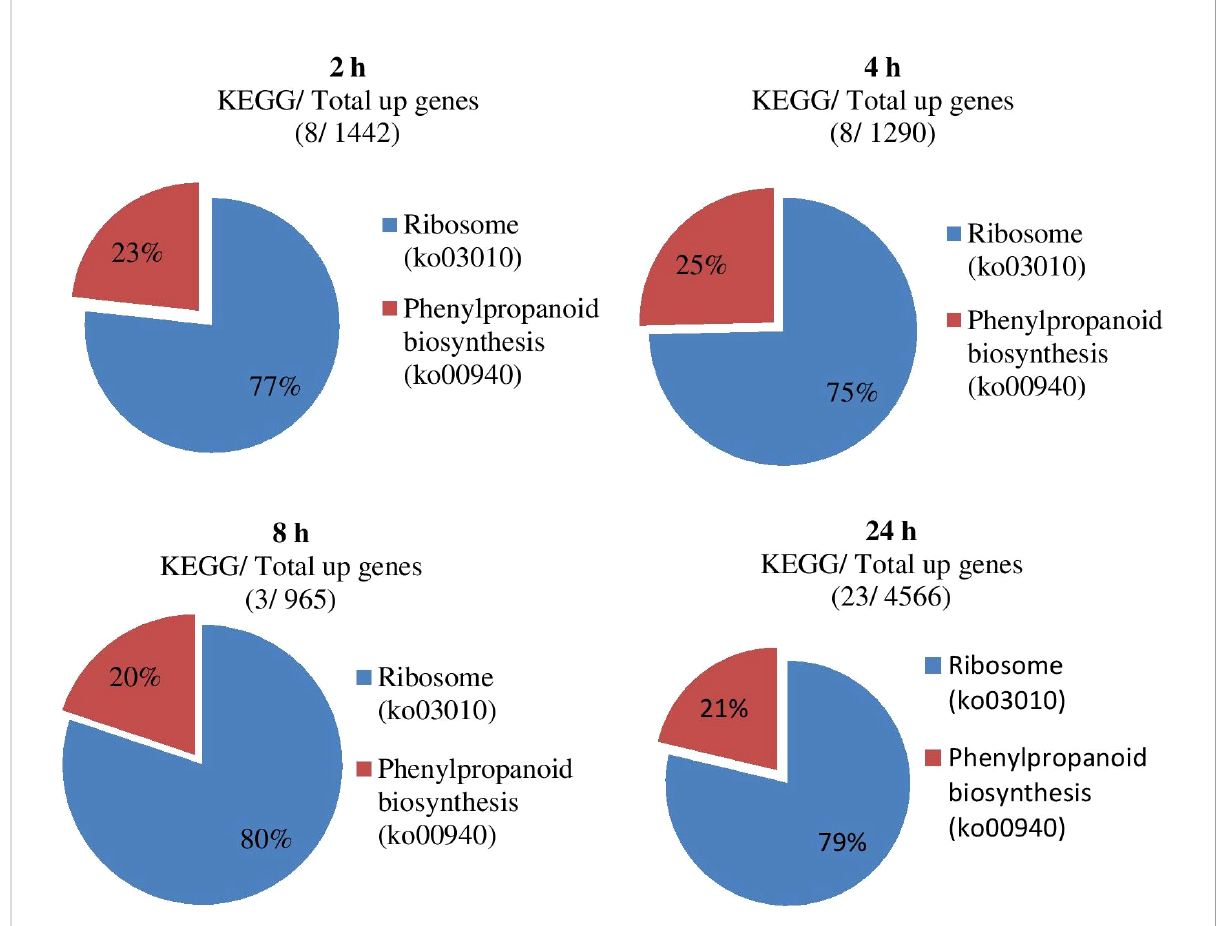
FIGURE 8 Impact of signi fi cant KEGG enrichment at different gene sets during stress